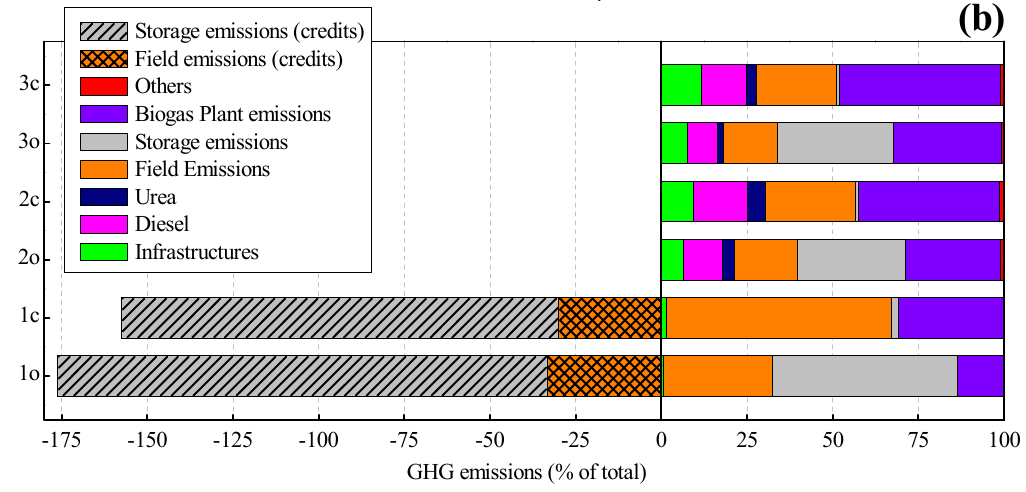
Figure 2. ( a ) GHG emissions, contribution analysis based on gaseous species (expressed as g·CO 2eq ·MJ − 1 el ). Results of the open-storage (1o, 2o, 3o), the closed-storage (1c, 2c, 3c) and the reference system ( i.e. , the Italian electricity mix) are included in the graph. Black thick line symbol refers to the net total emissions for the manure pathways. For the energy crops-based systems the GHG emissions associated to ILUC are included as a separate item; ( b ) Process contribution analysis of the total GHG emissions. The percentage values are referred to the total GHG emissions (ILUC excluded and without credits for manure pathways); for pathway 1o these amount to 589 gCO 2eq ·MJ − 1 el , for pathway 1c to 256 gCO 2eq ·MJ − 1 el